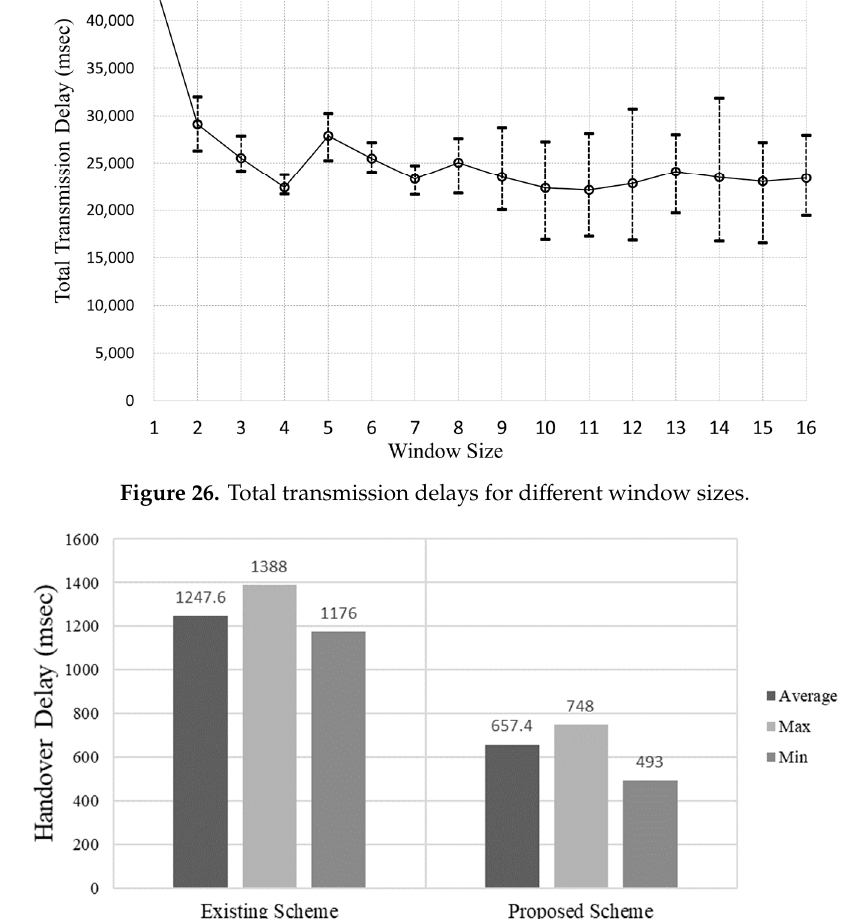
Figure 26. Total transmission delays for different window sizes.